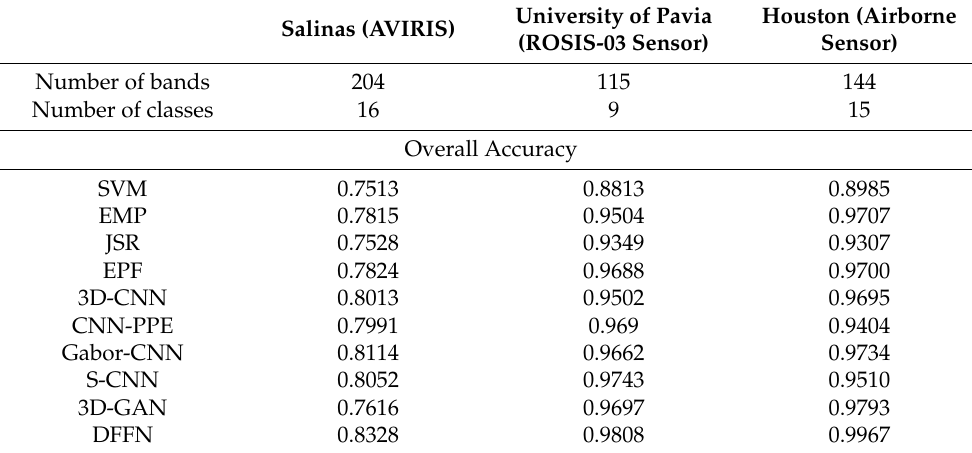
Table 10. Overall accuracy of support vector machines (SVM), extended morphological profiles (EMPs), joint spare representation (JSR), edge-preserving filtering (EPF), 3D-CNN, CNN with pixel– pair features (CNN-PPF), Gabor-CNN, Siamese CNN (S-CNN), 3D-generative adversarial network (3D-GAN), and the deep feature fusion network (DFFN) on three different datasets. University of Pavia Salinas (AVIRIS)